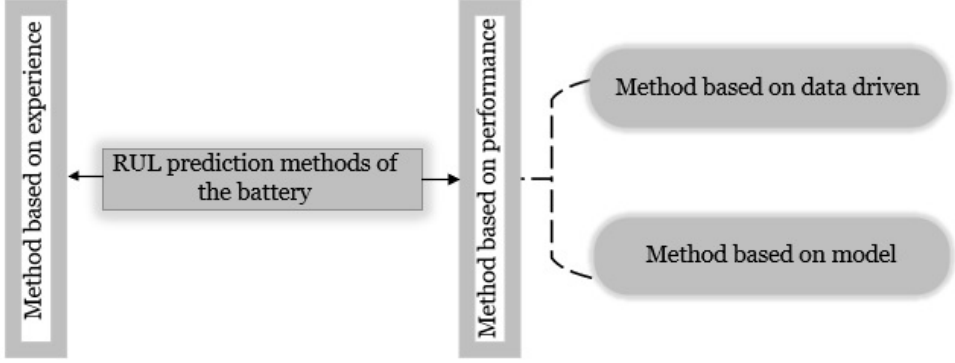
Figure 1. Classification of approaches for predicting remaining useful